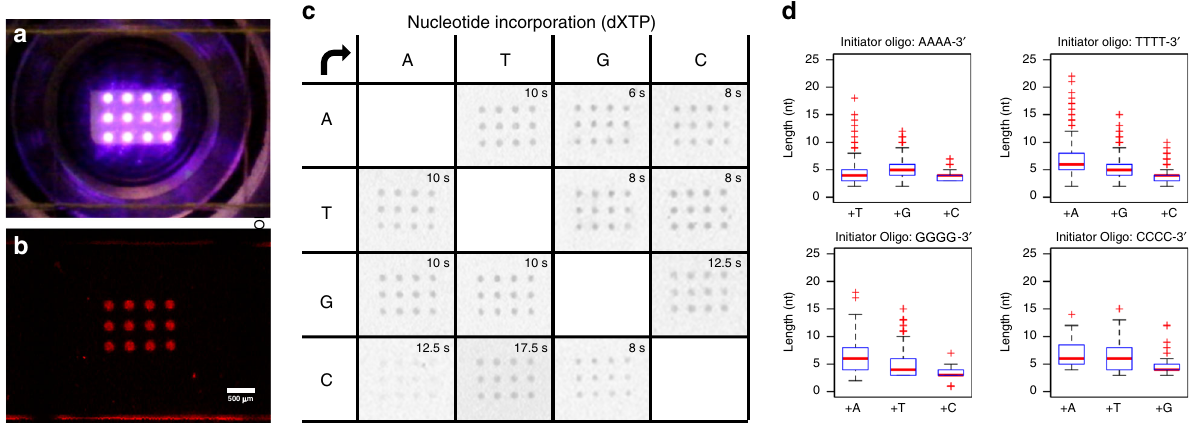
Fig. 2 Multiplex enzymatic synthesis optimization and base transition normalization. a Demonstration of UV irradiation of the array surface with 100 µ m circular spots arranged in a (3 ⋅ 4) patterned format on 1.2 mm 2 of surface area. UV irradiation is not limited to this particular patterning and may be pixel- wise (1920 × 1080) changed on-demand with our photolithographic system. Any spot on the surface is individually addressable in terms of spatial location and the total amount of UV irradiation time. b Visualization of G homopolymeric oligonucleotide synthesis post system optimization via the splint-end ligation of a probe sequence containing a 3 ′ -Cy3 fl uorophore using the (3 ⋅ 4) pattern. c Results of base transition normalization in which the total illumination time was adjusted for any base transition that may be encountered during multiplexed synthesis. The left axis indicates the composition of the last 4 bases on the 3 ′ -terminus of surface initiator oligonucleotide and the top axis indicates the nucleotide that was incorporated onto the respective initiator oligonucleotide. The optimal illumination time is indicated in each base transition box and was determined by splint-end ligated 3 ′ -Cy3 fl uorescent signal. d Box plots indicating NGS analysis of base transition normalization. Graphs show the normalized nucleotide (nt) extension length distribution for all possible base transitions with red pluses being statistical outliers. Source data are provided as a Source Data fi